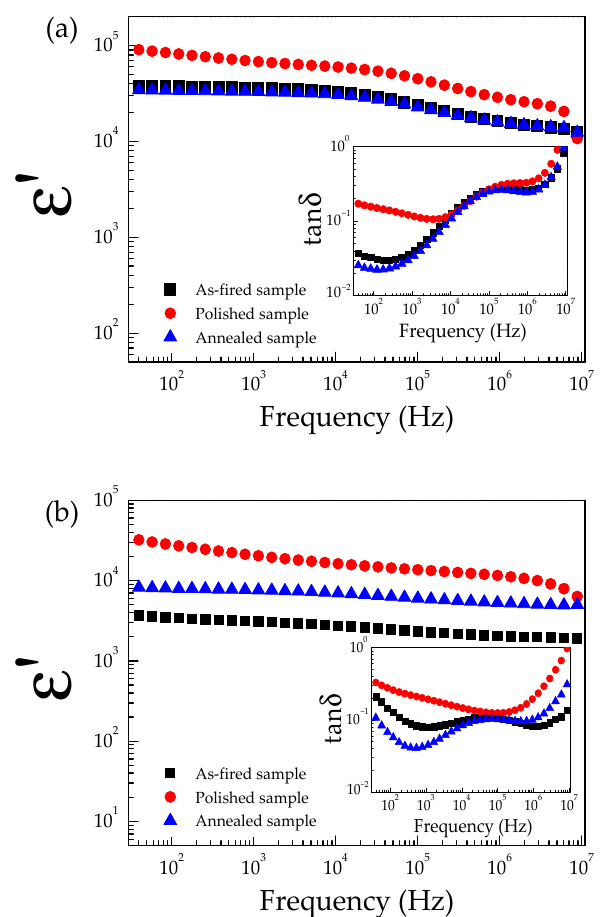
Figure 5. Frequency dependence of ε′ for ( a ) 0.5% CoNTO and ( b ) 1% CoNTO ceramics.